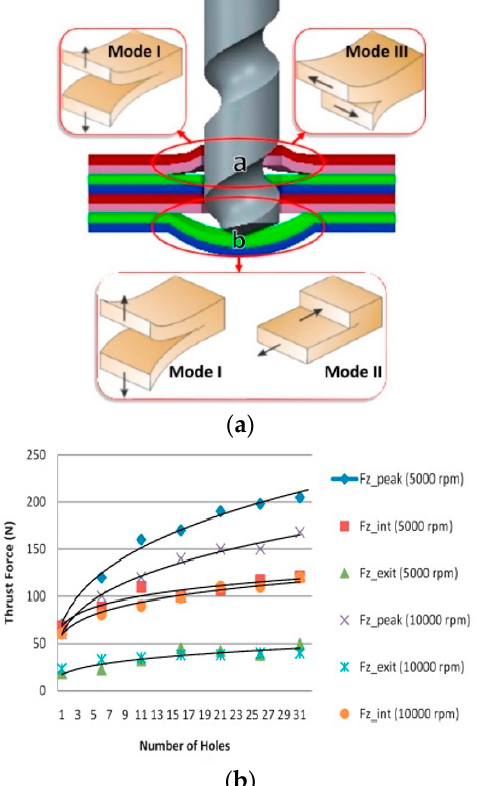
Figure 4. ( a ). Delamination phenomena depicting different modes during a-peel-up and b-push- out type [68]; ( b ) Rotational speed influence on thrust forces and holes number [69]. type [68]; ( b ) Rotational speed influence on thrust forces and holes number